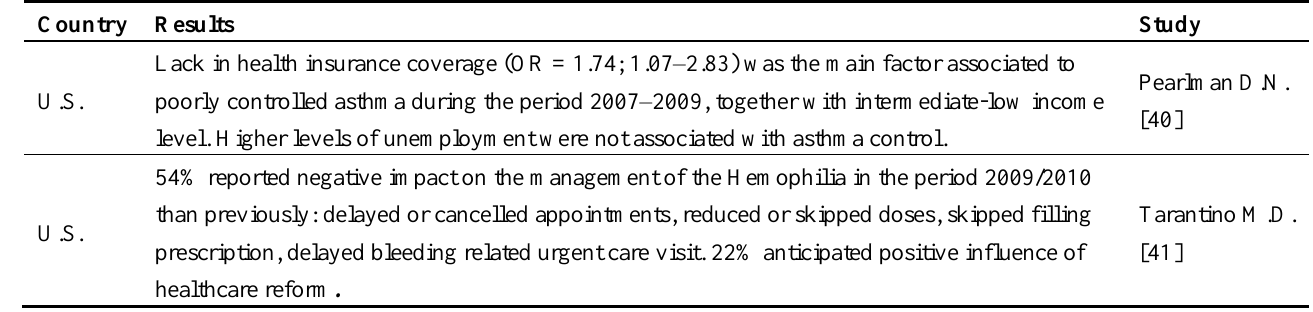
Table 5. Summary of the impact of the 2008 economic crisis on chronic conditions.